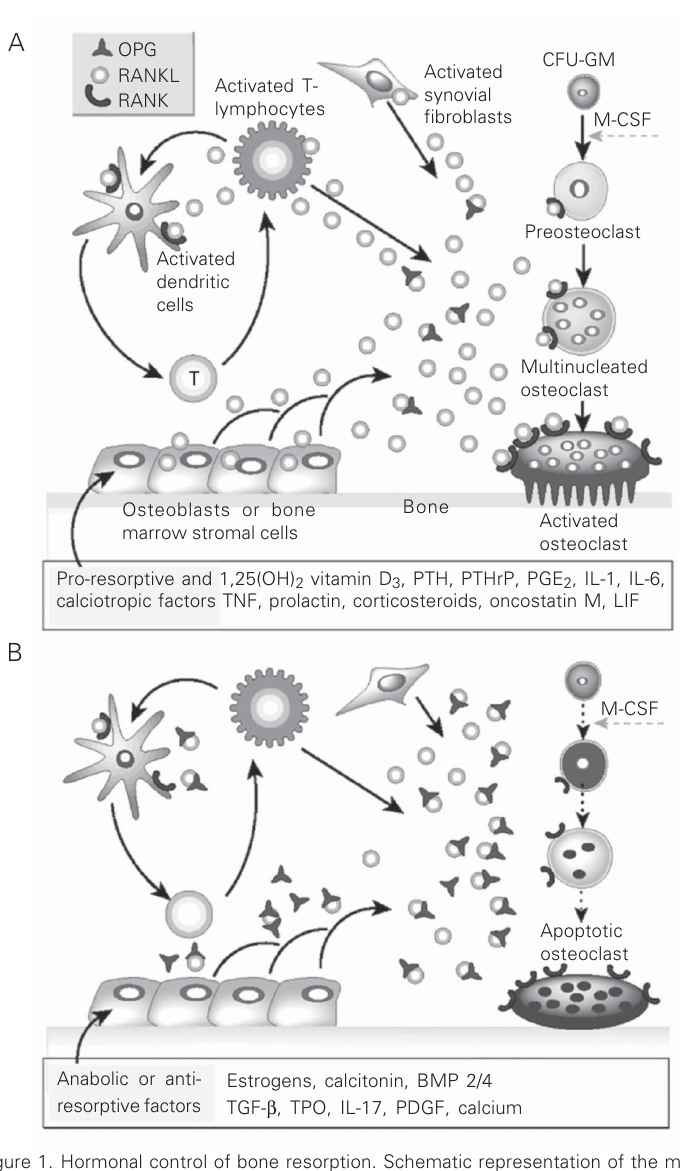
Figure 1. Hormonal control of bone resorption. Schematic representation of the mechan- ism of action of A , pro-resorptive and calcitropic factors and B , anabolic and anti- osteoclastic factors. Receptor activator of nuclear factor kappa B ligand (RANKL) expres- sion is induced in osteoblasts, activated T-cells, synovial fibroblasts and bone marrow stromal cells, and RANKL subsequently binds to its specific membrane-bound receptor activator of nuclear factor kappa B (RANK), thereby triggering a network of tumor necrosis factor (TNF) receptor-associated factor-mediated kinase cascades that promote osteoclast differentiation, activation and survival. Conversely, osteoprotegerin (OPG) expression is induced by factors that block bone catabolism and promote anabolic effects. OPG binds and neutralizes RANKL, leading to a block in osteoclastogenesis and decreased survival of pre-existing osteoclasts. CFU-MG = colony-forming units-granulocyte-macrophage; M- CSF = macrophage colony-stimulating factor; PTH = parathyroid hormone; PTHrP = PTH- related peptide; PGE 2 = prostaglandin E 2 ; IL = interleukin; LIF = leukemia inhibitor factor; BMP 2/4 = bone morphogenetic proteins 2 and 4; TGF-ß = transforming growth factor ß; TPO = thrombopoietin; PDGF = platelet-derived growth factor. (Reproduced, with permis- sion, from